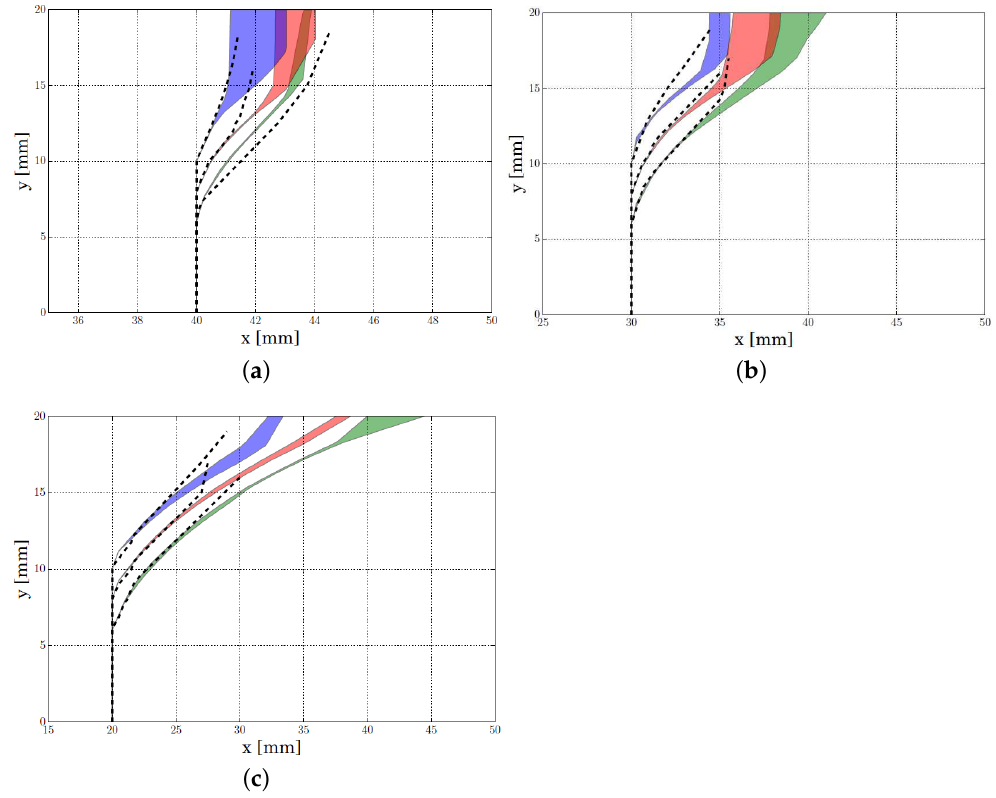
Figure 14. Crack trajectory obtained with the lattice model (in dashed line) and the envelope area of the experimental crack patterns for different initial notch lengths a , i.e., green: a = 6 mm, red: a = 8 mm and blue: a = 10 mm and different notch eccentricity d ( a ) d = 10 mm, ( b ) d = 20 mm, ( c ) d = 30